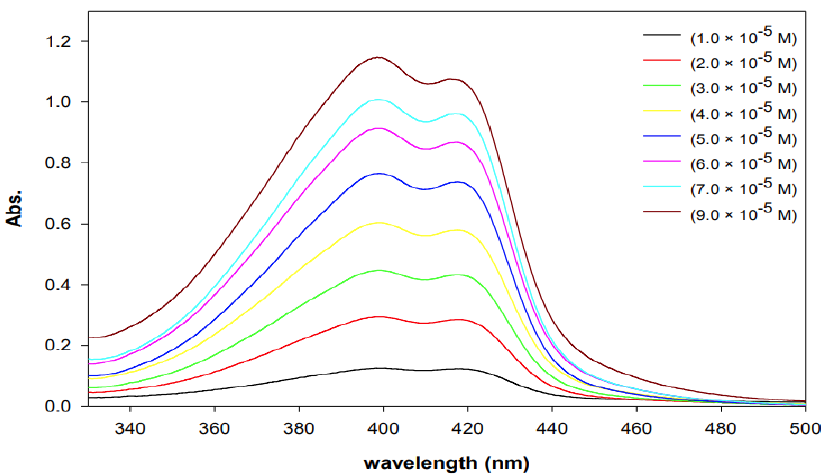
Figure 4. The electronic spectra of the AMFP – TCNE CT complex using different concentrations of AMFP in DCE. AMFP in